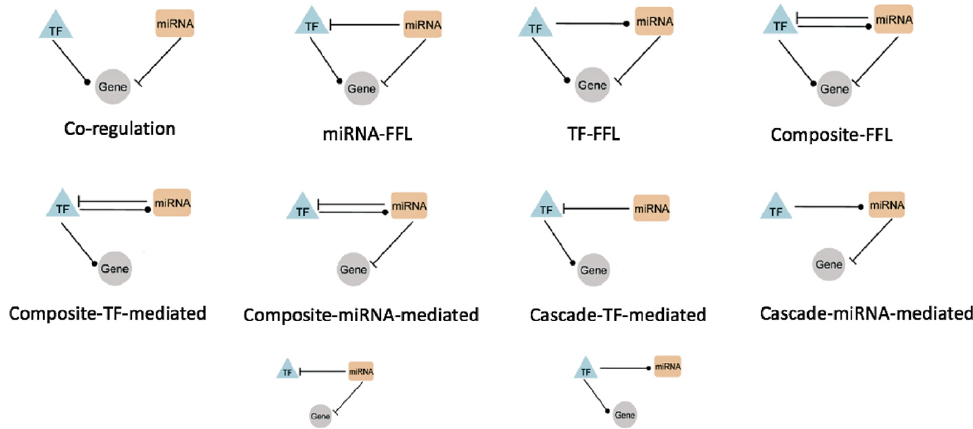
Figure 1: 3-node motifs in miRNA & TF synergistic regulatory networks. In FFLs the gene is regulated via two paths: (1) a direct regulation by a main regulator (TF/miRNA) and (2) an indirect regulation through an intermediate regulator (miR- NA/TF) which is itself regulated by the main regulator. Composite-TF/miRNA-mediated: mutual regulation of TF and miRNA besides regulation of the target gene by only one of them. Cascade-TF/miRNA-mediated: are non-loop forms, including an indirect effect of the main regulator (TF/miRNA) on the target gene only via another type of regulator (miR- NA/TF). The 3 rd row shows two non-cooperative motifs where the target gene is not cooperatively regulated.